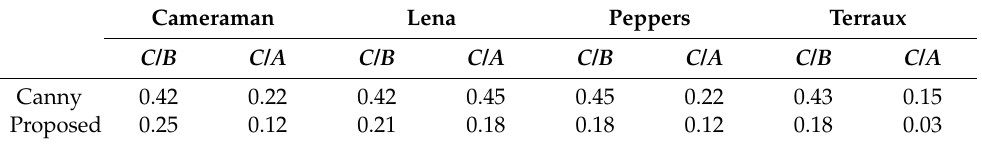
Table 2. The comparison of / C B and / C A values of two algorithms on four standard digital images.